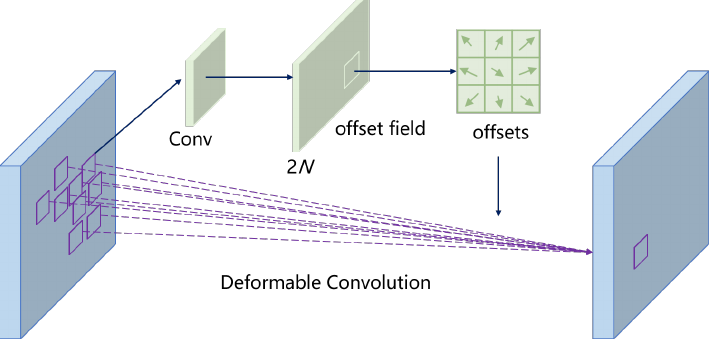
Figure 4. Illustration of 3 × 3 deformable convolution